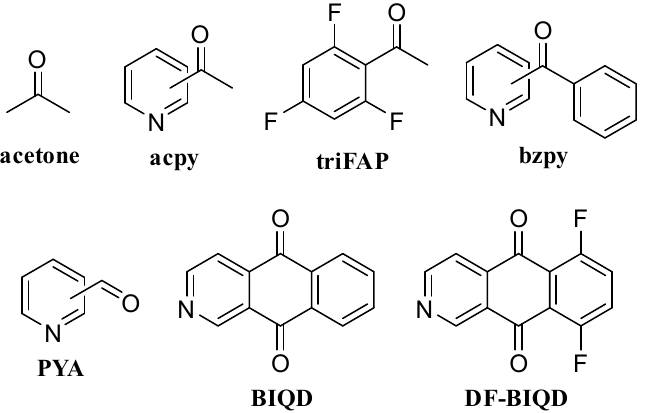
Figure 9. Ketones and aldehydes used for the derivatization of UFAs and determination of their double bond location.